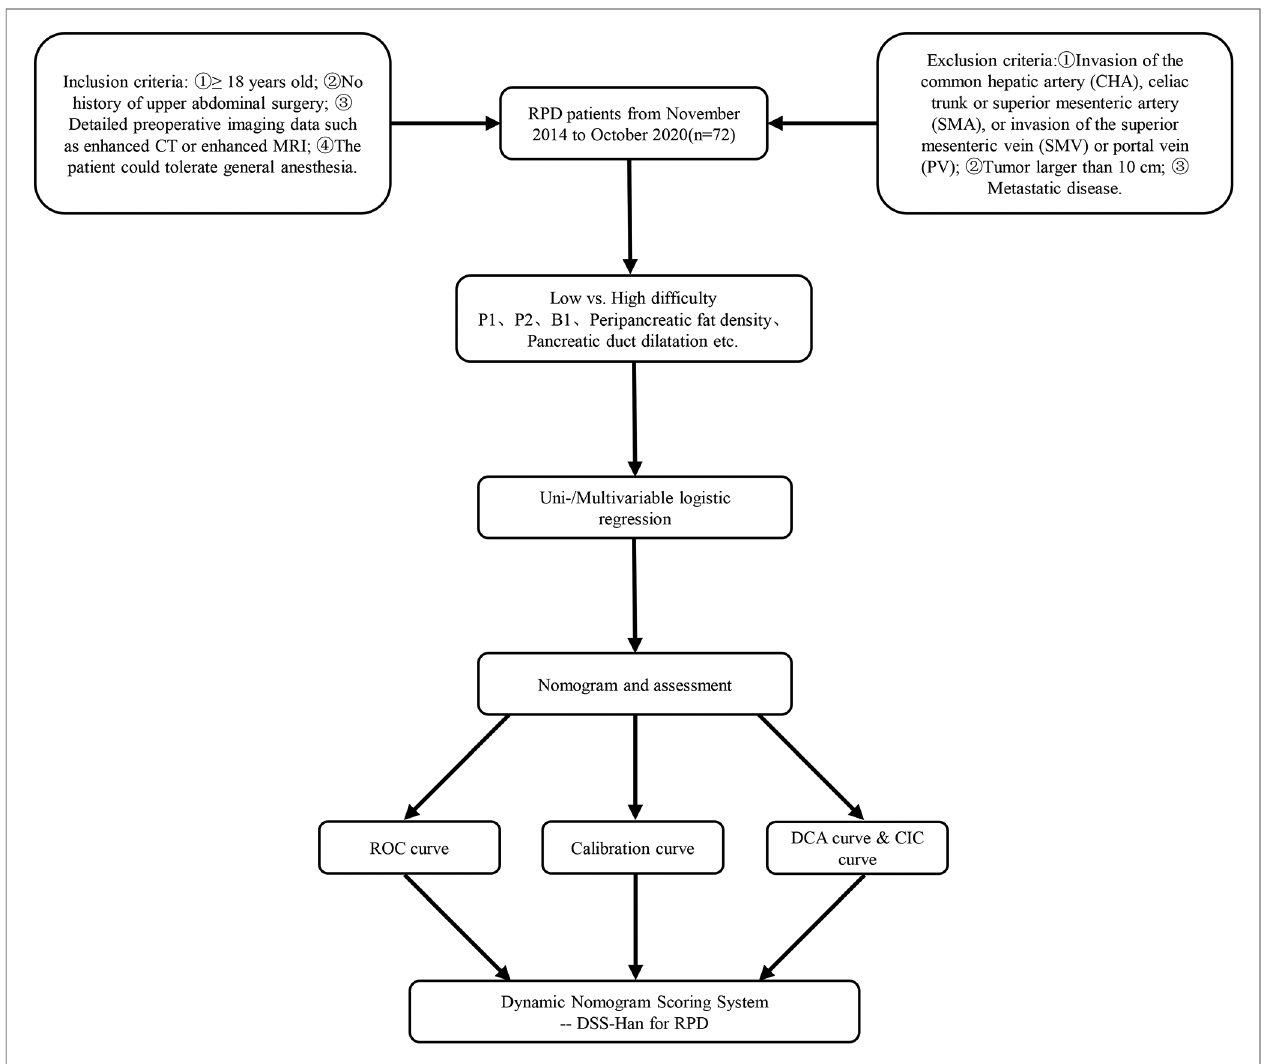
FIGURE 3 | Flow chart of the